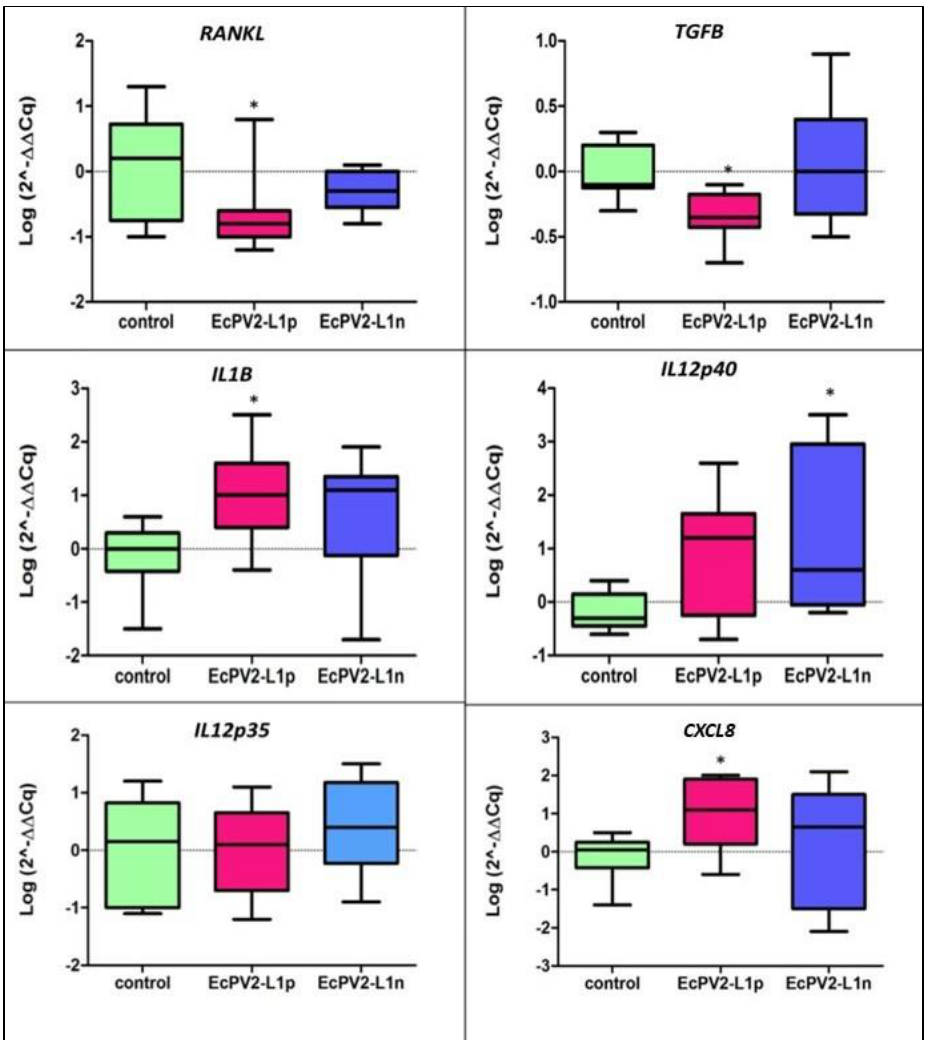
Figure 4. Horse gene expression results. Data are represented as box-and-whisker plots displaying median and interquartile ranges (boxes) and minimum and maximum values (whiskers). Differences (control vs. EcPV2-L1p; control vs. EcPV2-L1n) were evaluated through ANOVA followed by Dunnett’s multiple comparison test or a Kruskal–Wallis test followed by Dunn’s multiple comparison test; * p < 0.05.